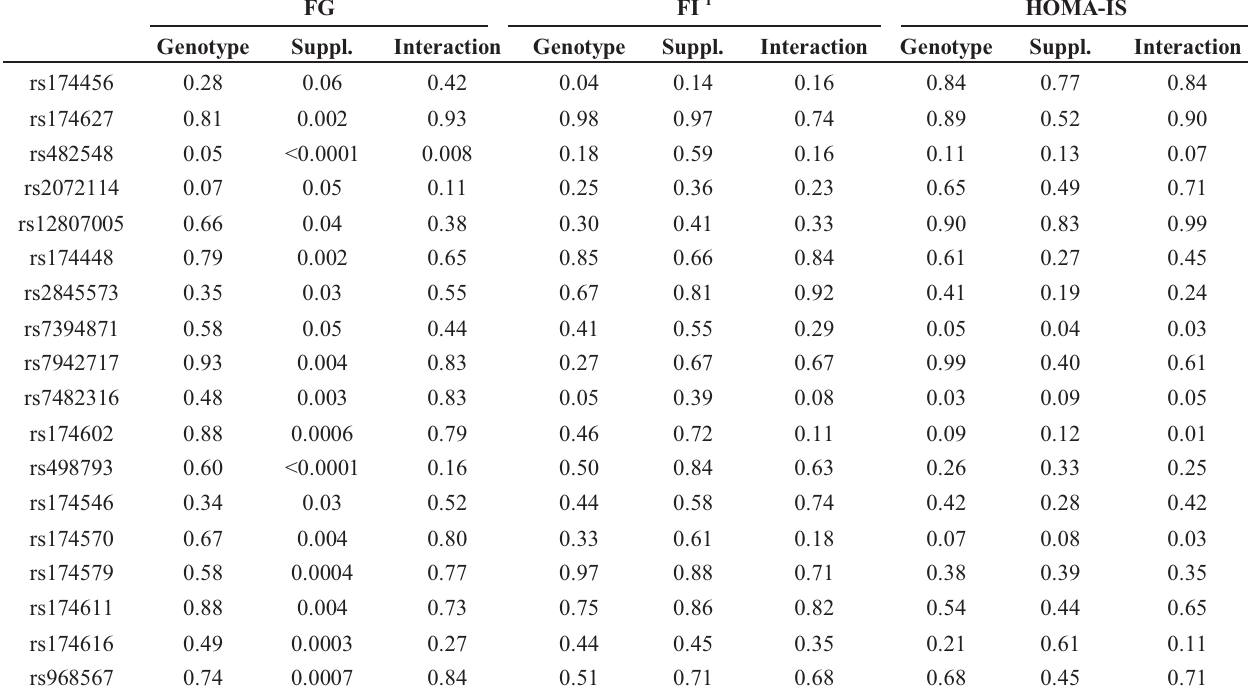
Table 2. Effect of the genotype, the n-3 PUFA supplementation and the interaction (genotype by supplementation) on fasting glucose (FG), fasting insulin (FI) and homeostasis model assessment of insulin sensitivity (HOMA-IS) levels ( n = 208).